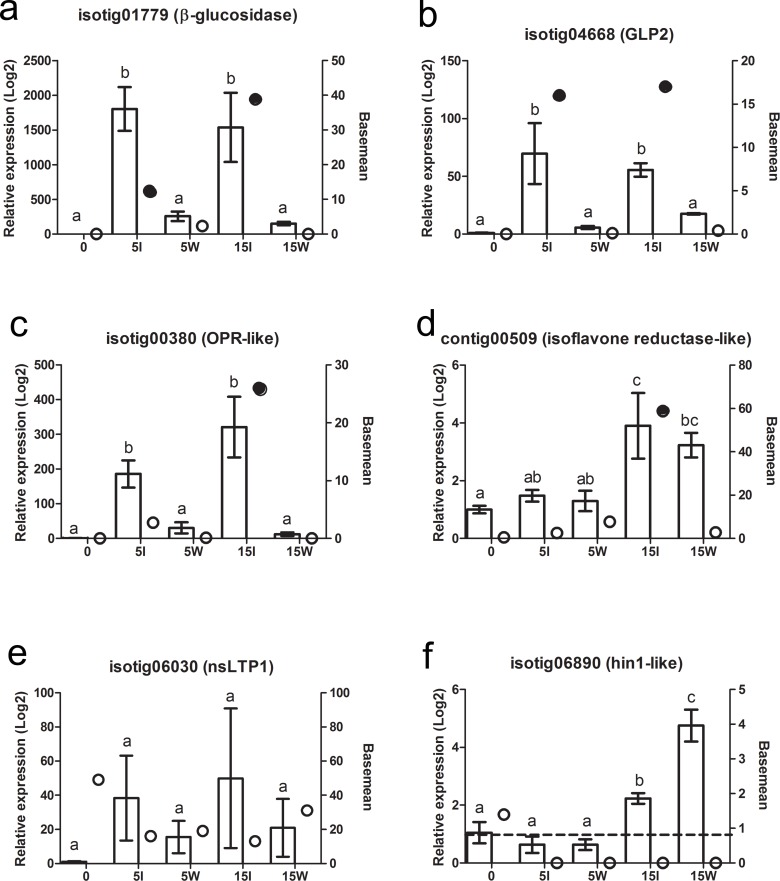
Expression pattern of selected transcripts in an independent Norway spruce material compared to the RNAseq frequency data.Isotig01779, beta-glucosidase (a); isotig04668 GLP2 (b); isotig00380, OPR-like (c); contig00509, isoflavone reductase-like (d); isotig06030, ns-LTP (e) and isotig06890, hin1-like (f). The columns indicate relative expression levels over the control, determined with qPCR, for each time point and treatments. The bars indicate the standard error (SE) and superscript letters indicate significant differences between treatments (P<0.05, Kruskal-Wallis test with Dunn´s post test), N = 3. The circles indicate the basemean data reported by DEseq, where shaded symbols were significantly different from un-treated bark.